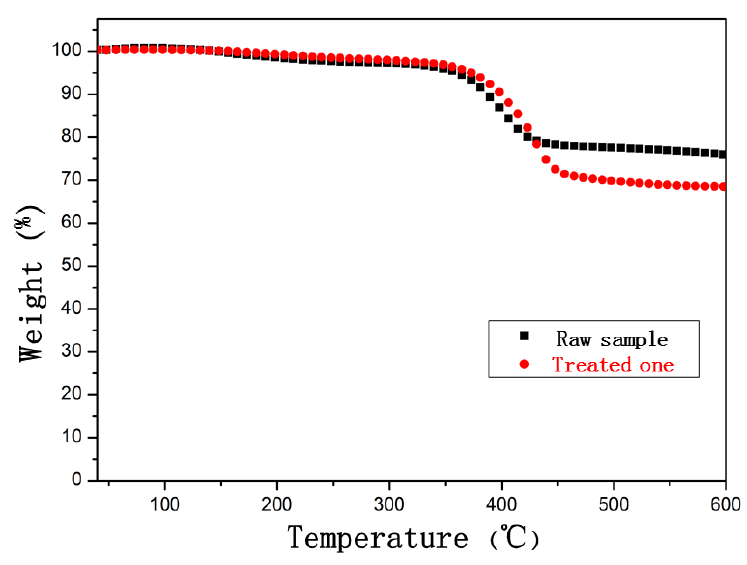
Figure 9. TGA curves of CFRE composites before and after saturated moisture absorption treatment.